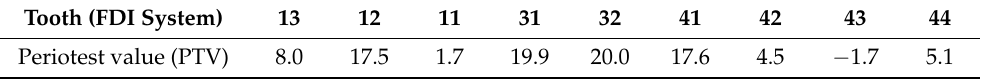
Table 1. Periotest value.